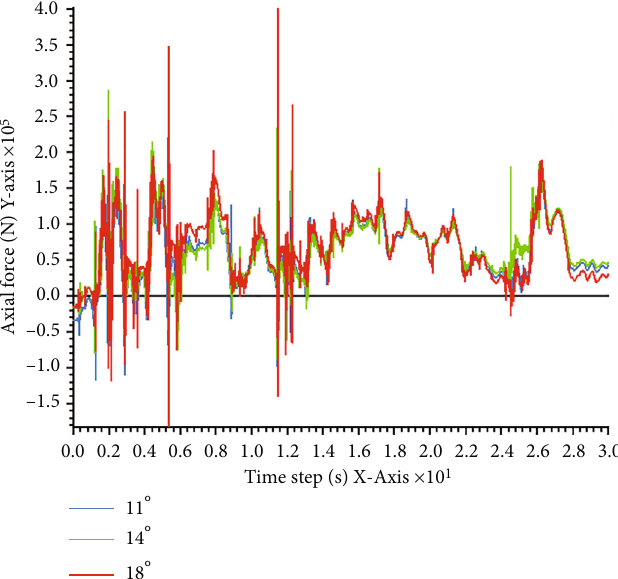
Figure 16: Distribution of dynamic earth pressure at W1 under di ff erent anchor